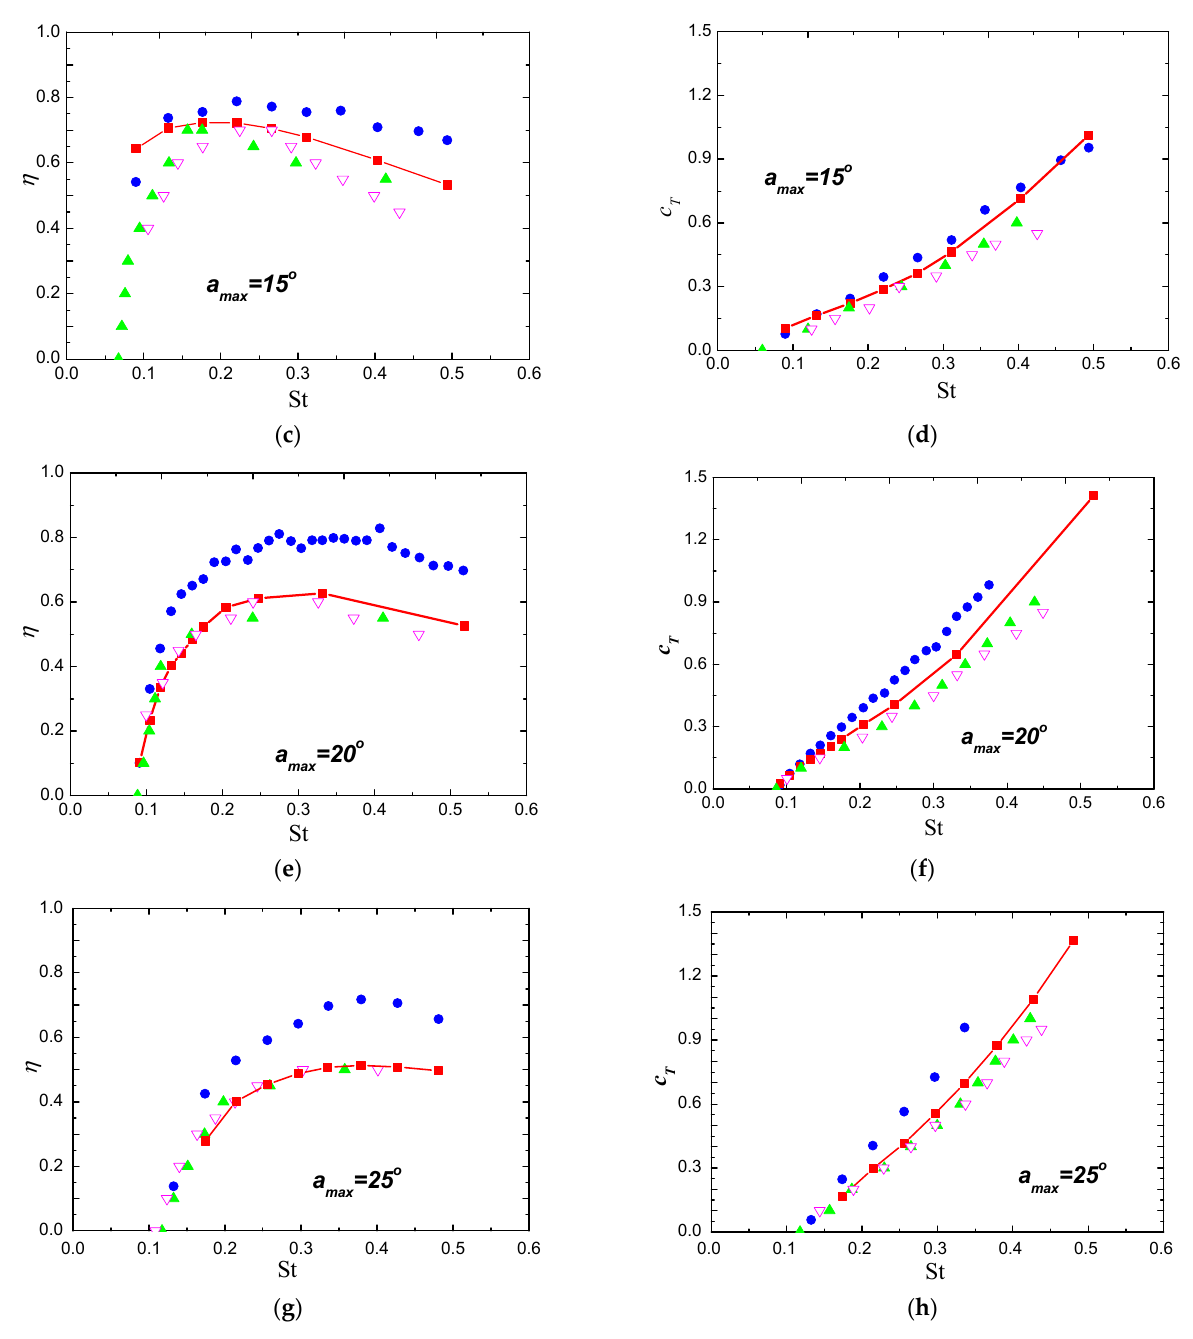
Figure 8. Comparisons of the propulsive efficiency η and the thrust coefficient c T with previous computational and exper- imental results. at different a max. ( a ) Propulsive efficiency comparison with a max = 10°; ( b ) Thrust coefficient comparison with a max = 10°; ( c ) Propulsive efficiency comparison with a max = 15°; ( d ) Thrust coefficient comparison with a max = 15°; ( e ) Propul- sive efficiency comparison with a max = 20°; ( f ) Thrust coefficient comparison with a max = 20°; ( g ) Propulsive efficiency com- parison with a max = 25°; ( h ) Thrust coefficient comparison with a max = 25°. (The red curve is the CFD results of this paper, is the result of Anderson’sAnderson experiment, is the result of Read’sRead experiment, is the result of Schoveiler’sSchoveiler experiment).